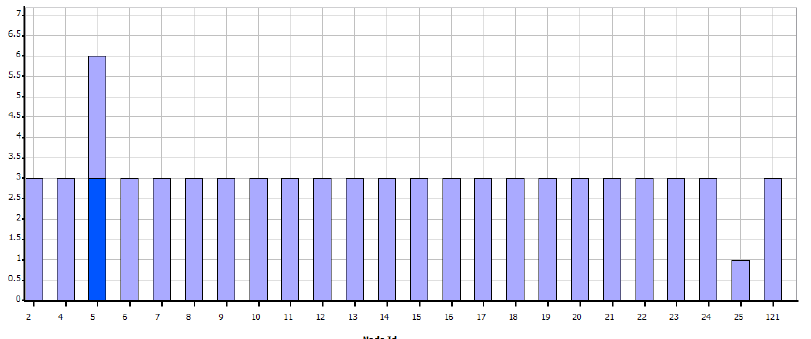
Figure 13. Data sent by node—Zigbee.